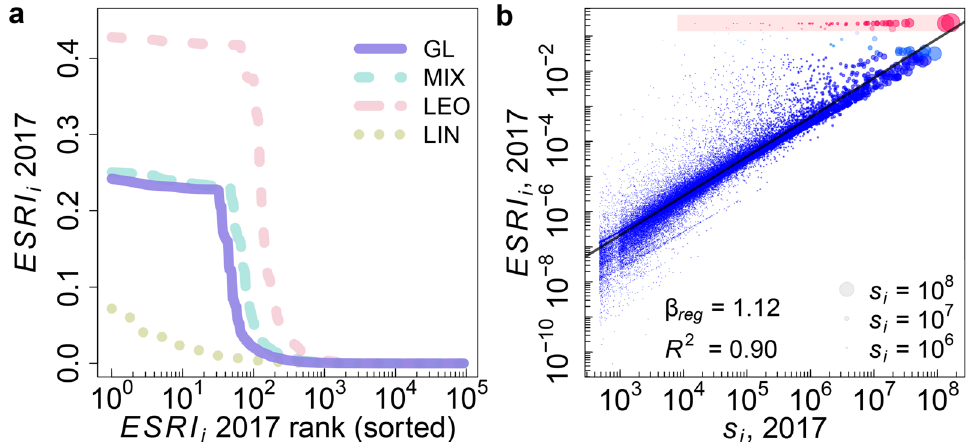
Figure 3. Economic systemic risk of companies. ( a ) Economic systemic risk profile (distribution) ESRI i of n = 91, 595 companies in linear-log scale for 2017. Distributions are rank-ordered, meaning the most risky company is to the very left. The blue line shows the result for the realistic GL scenario (production functions according to industry classification and classifying produced goods as essential or not). A plateau exists around an ESRI of 0.23, containing 32 firms for GL. There is a steep decline to ESRI i ∼ 0.05 from rank 33 to 63. 165 firms have an ESRI larger than 0.01. For comparison the MIX scenario (light blue) is shown (production functions according to industry classification only). As the limiting cases we show the scenarios LIN (green), where all firms have linear production functions and LEO (red), where all firms have Leontief production functions. The tail of the ESRI profile decays as an approximate power-law. ( b ) ESRI plotted against firm strength (firm-size) in log-log scale. Symbol size represents strength s i , red symbols belong to the plateau, emphasised by the shaded area. We find large and small companies in the plateau, suggesting that very high ESRI is not determined by size, even though the correlation of ESRI and strength for the bulk of the companies is